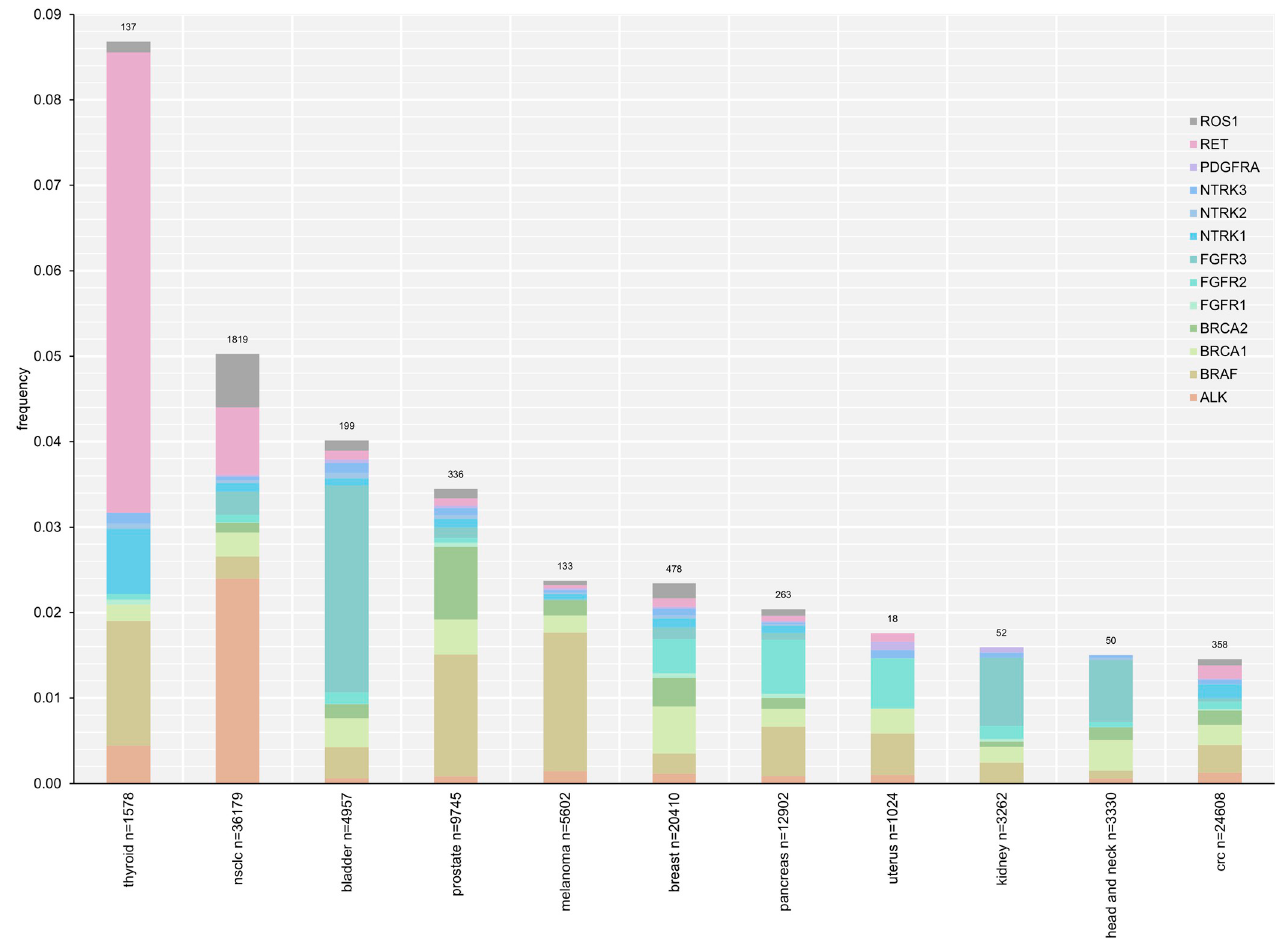
Fig 4. Frequencies of targetable known/likely rearrangements in common tumor types detected by F1CDx between 2018 and 2020. Source: from over 504,000 Foundation Medicine profiles consented for secondary research, 191,575 unique US patients tested with F1CDx from Jan. 14, 2018 through Mar. 31, 2021. CRC = colorectal cancer; NSCLC = non-small cell lung cancer.